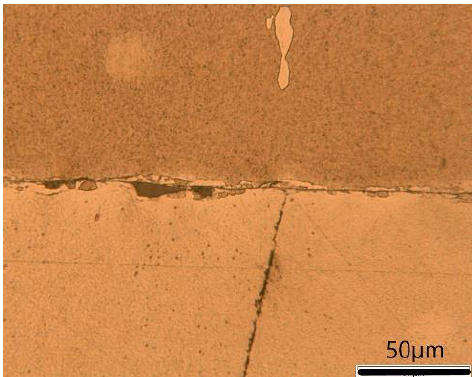
Figure 5. Micrograph of the bonding interface. SPS joined at 975 °C for 10 min from a sample with a rough machined surface.